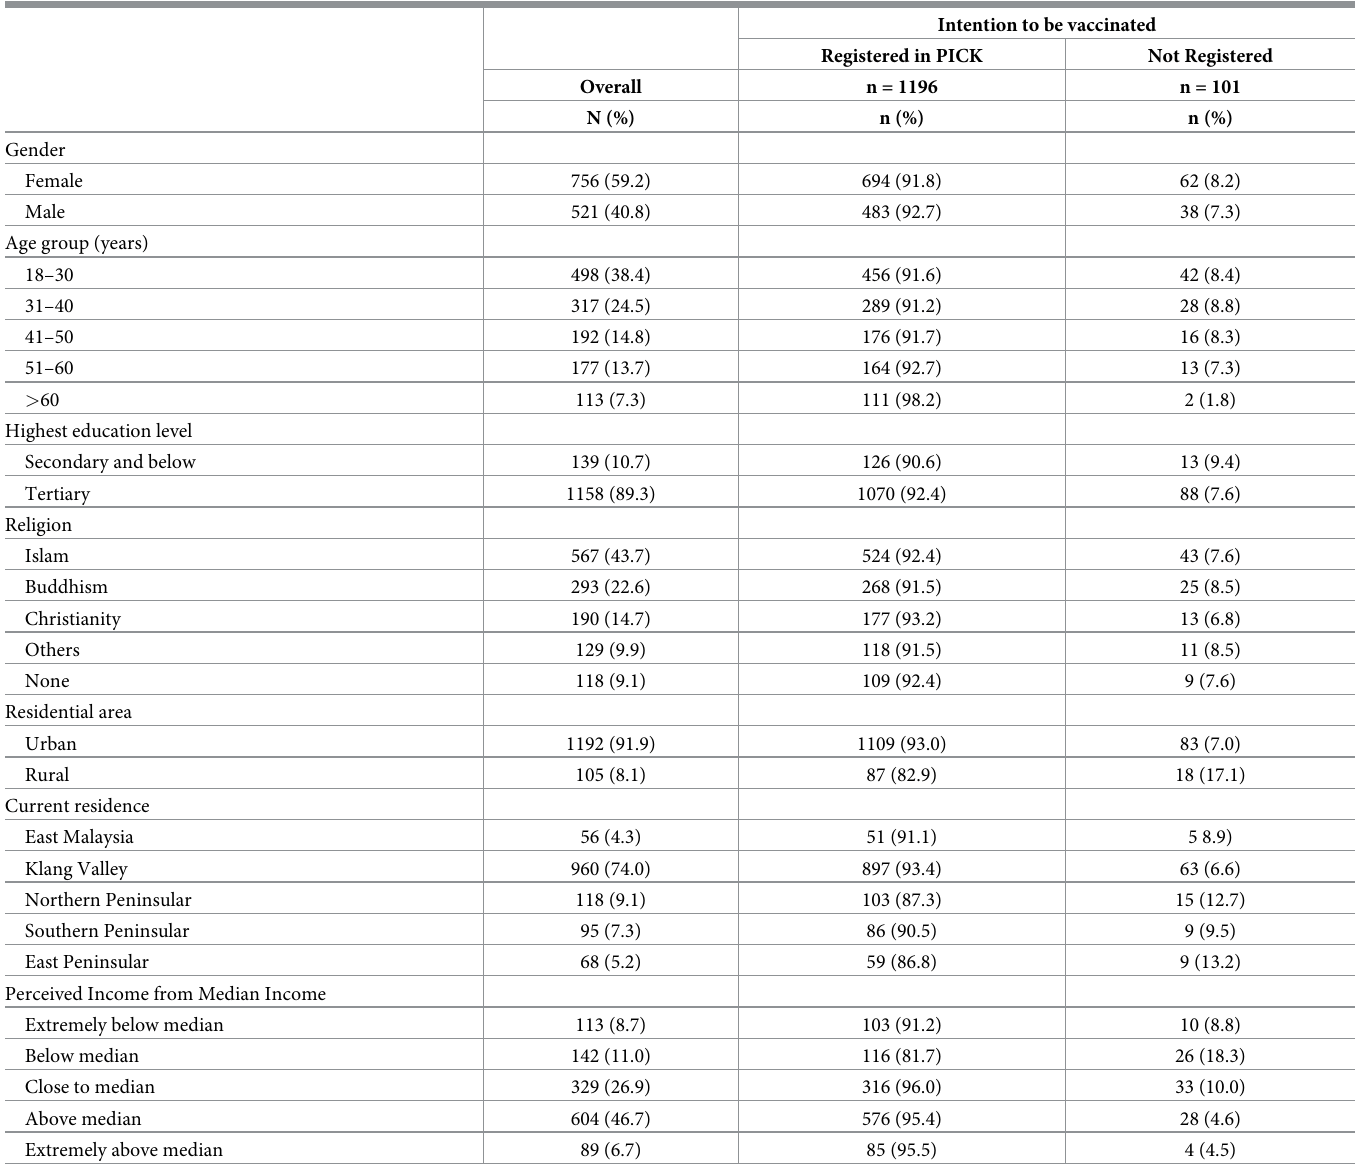
Table 2. Demographics and COVID-19 vaccination registration